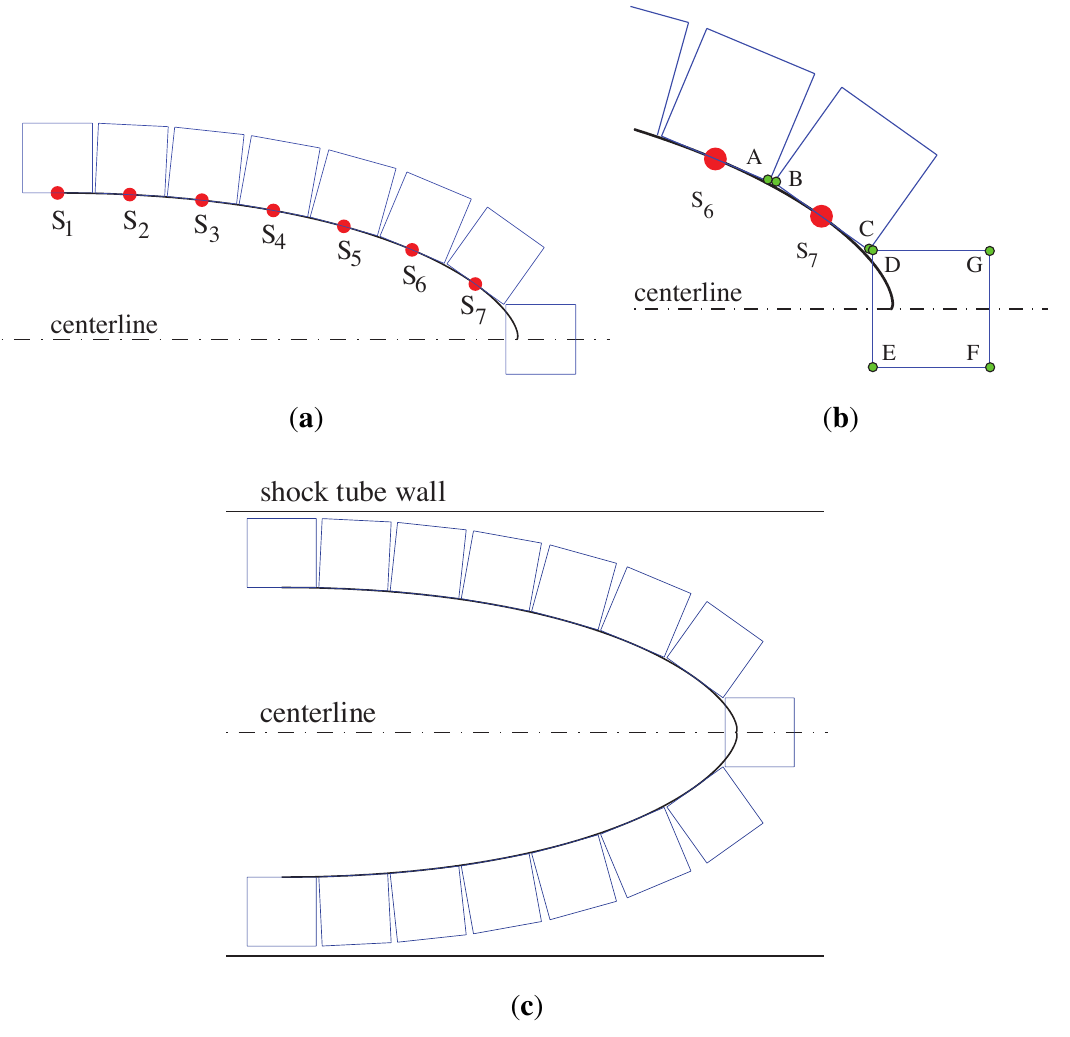
Figure 2. Procedure to place 15 square-shaped obstacles along a logarithmic spiral. ( a ) Mark points along the logarithmic spiral curve; ( b ) Place a square obstacle at the focal region; ( c ) Complete obstacle